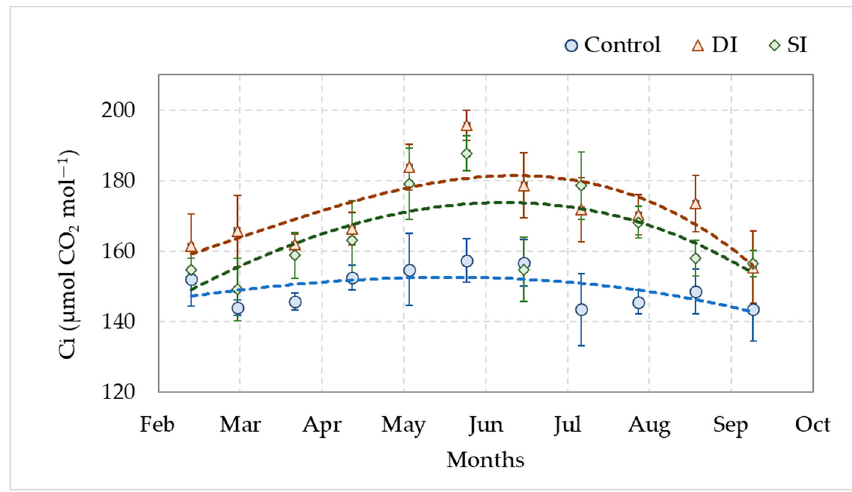
Figure 11. Effect of drip irrigation (DI), subsurface irrigation (SI), and bubbler irrigation (control) systems on the intercellular CO 2 concentration (Ci) of date palm (Khalas cv.). Each data point for SI and DI systems represents an average of 50, 75, and 100% ETc levels, whereas it is at 100% ETc level for control during 2020–2021.